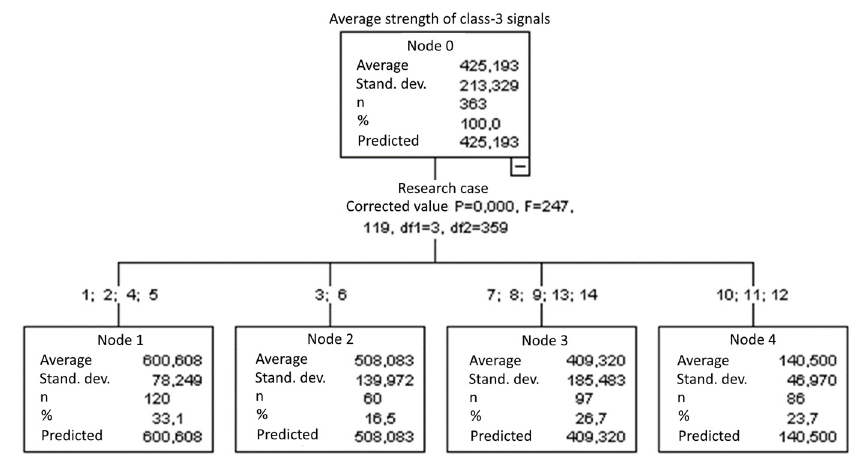
Figure 23. Classification tree for the average strength of class-3 signals.